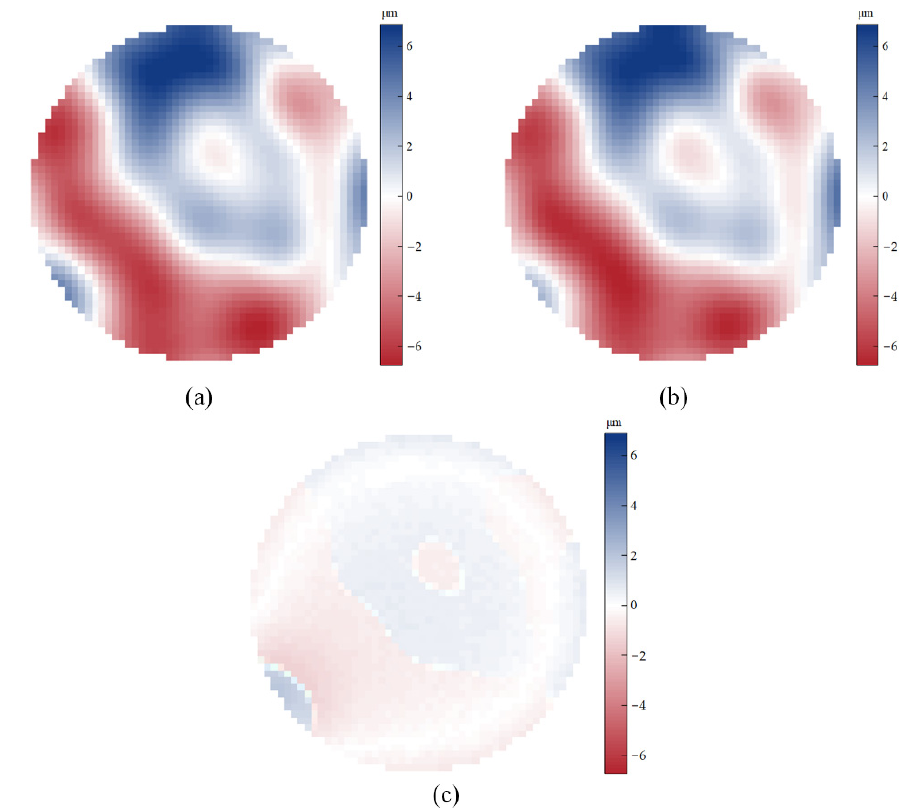
Figure 11. Different shapes of the deformable mirror: ( a ) shape of the deformable mirror controlled by the fixed coefficient SPGD algorithm; ( b ) shape of the deformable mirror controlled by the adaptive coefficient SPGD algorithm; ( c ) difference phase map of two shapes of the deformable mirror.